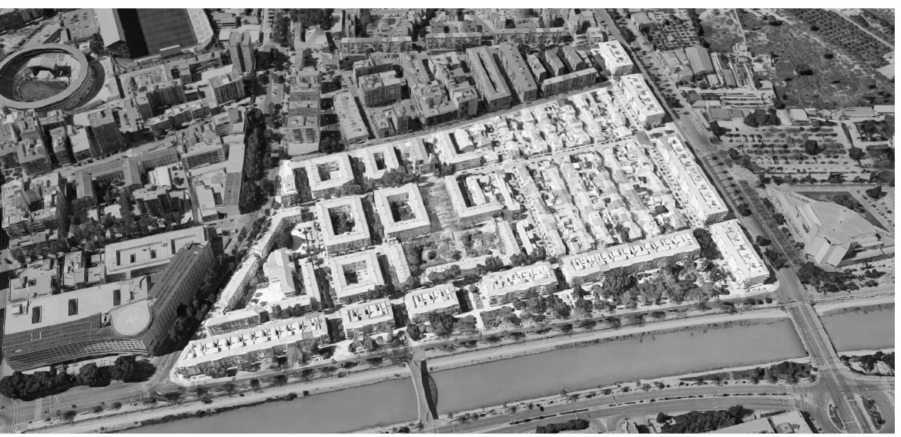
Figure 2. Aerial view of Vistabella neighborhood (1958). Authors’ image based on Google Maps 3D View.